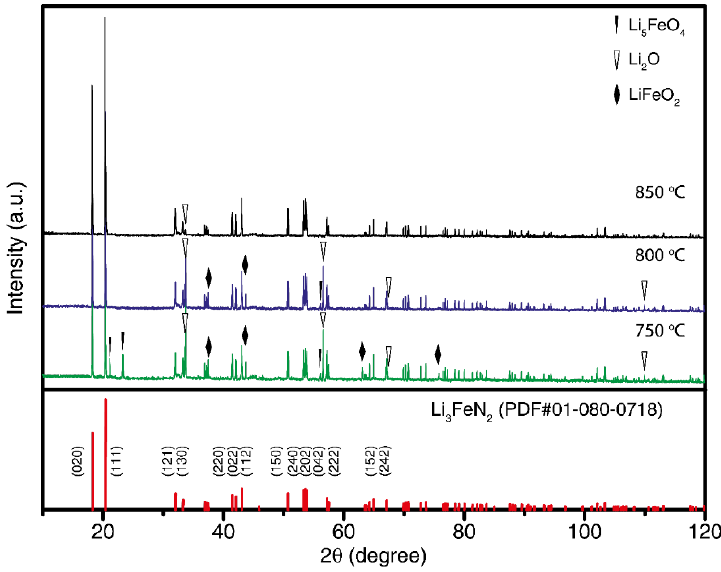
Figure 3. XRD patterns of Li 3 FeN 2 after heat treatment at 750, 800, and 850 °C for 10 h in N 2 atmosphere. The lines in the bottom indicate the diffraction positions of the Li 3 FeN 2 structure (PDF #01- 080-0718).